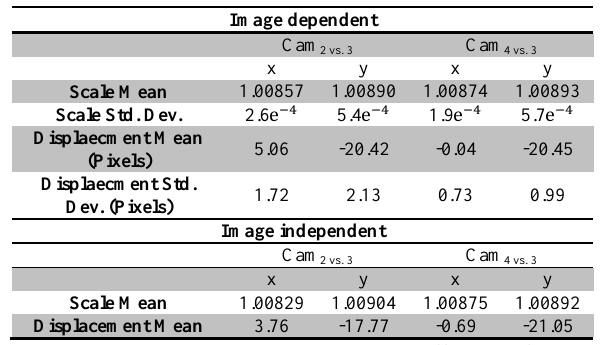
Table 3. Summarized systematic errors coefficients of image dependent and image independent approach